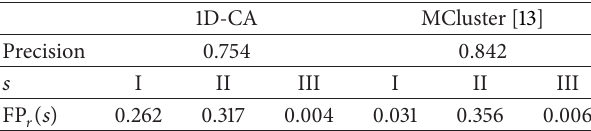
Table 1: Performance